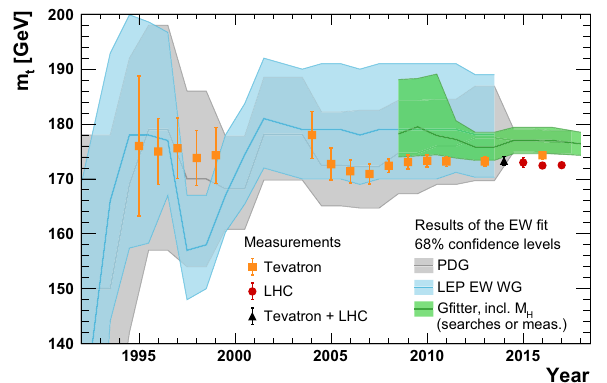
Fig. 1 Prediction of the top quark mass versus year as obtained by various analysis groups using electroweak precision data (grey [6], light blue [5], green [7]). The bands indicate the 68% confidence level. The direct m t measurements after the top quark discovery are displayed by the data points (orange [3,4,12,16,17], red [14,15,21], black [13])